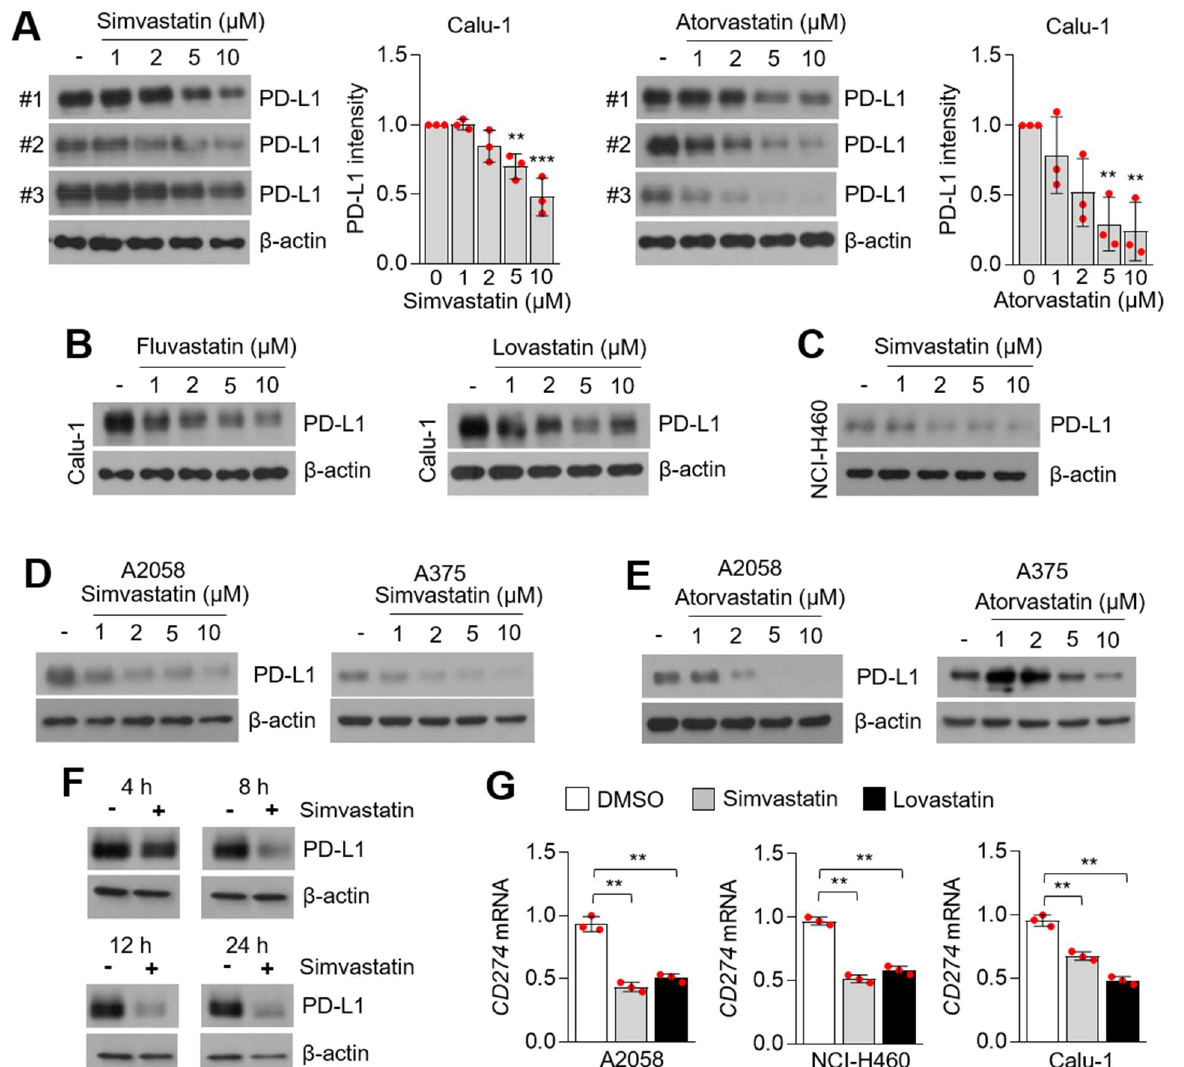
Figure 2. PD-L1 is decreased in statins-treated lung cancer and melanoma cells. ( A ) PD-L1 expression in simvastatin and atorvastatin-treated Calu-1 lung cancer cells. Calu-1 cells were incubated with simvastatin and atorvastatin at the indicated concentration for 12 h. DMSO was used for vehicle control (-). PD-L1 protein levels were measured by using western blotting and PD-L1 protein intensity was both quantified and represented by Image J and Graphpad Prism. Each PD-L1 protein level in the statins-treated sample was compared to the vehicle sample. The values represent the mean ± SD for the three independent experiments (#1, #2, and #3) performed. ** p < 0.01 and *** p < 0.001 by one-way ANOVA, followed by an appropriate post hoc test for the comparison between two experimental groups. ( B ) PD-L1 expression in fluvastatin and lovastatin-treated Calu-1 lung cancer cells. Calu-1 cells were incubated with fluvastatin and lovastatin at the indicated concentration for 12 h. ( C ) PD-L1 expression in simvastatin-treated NCI-H460 lung cancer cells. Different concentrations of simvastatin were treated for 12 h, as indicated. ( D , E ) PD-L1 expression in simvastatin ( D ) or atorvastatin ( E )-treated A375 and A2058 melanoma cells. Different concentration of statins were treated for 12 h. ( F ) PD-L1 expression in simvastatin-treated A2058 melanoma cells in a time-dependent manner, as indicated. ( G ) CD274 mRNA-encoding PD-L1 protein expression in simvastatin (5 µ M for 8 h) and lovastatin (5 µ M for 8 h)-treated A2058, NCI-H460, and Calu-1 cells. CD274 mRNA was measured by using qRT-PCR. Values represent mean ± SD. Experiments were performed in triplicates. ** p < 0.01 by one-way ANOVA, followed by an appropriate post hoc test for the comparison between two experimental